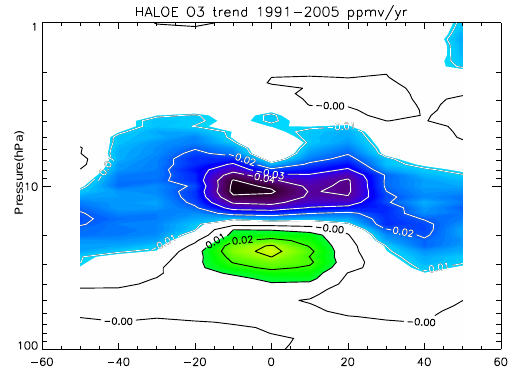
Figure 3. The O 3 linear trend calculated from MLS data from Au- gust 2004 to May 2013. Contour lines are shown at ± 0.01, 0.02, 0.03, 0.04, 0.06, 0.08ppmvyear − 1 . The MLS data has been sorted into twelve 10 ◦ latitude bins from 60 ◦ S to 60 ◦ N. Regions where the magnitude of the trend is <0.01ppmvyear − 1 are indicated in